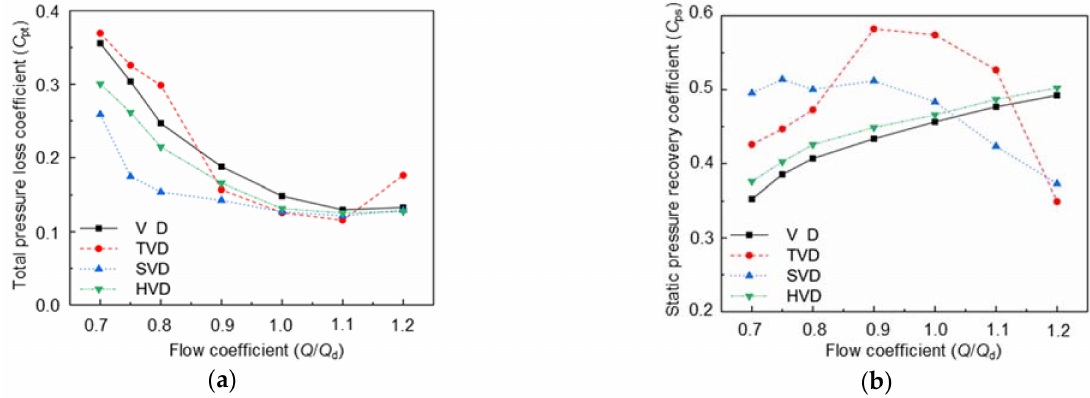
Figure 7. Performance comparison for different diffusers: ( a ) total pressure loss coefficient; ( b ) static pressure recovery coefficient.